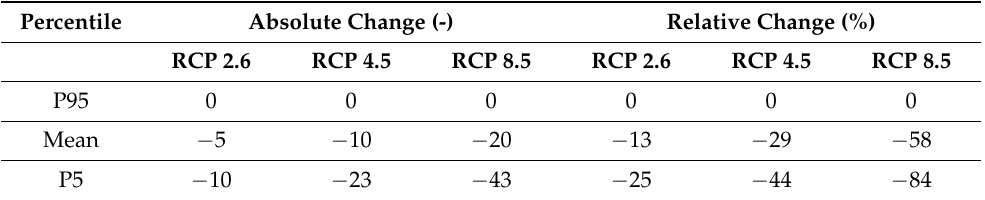
Table 4. Statistics on the absolute change in yearly mean FTC crit for RCPs 2.6, 4.5 and 8.5 and south-west (SW)